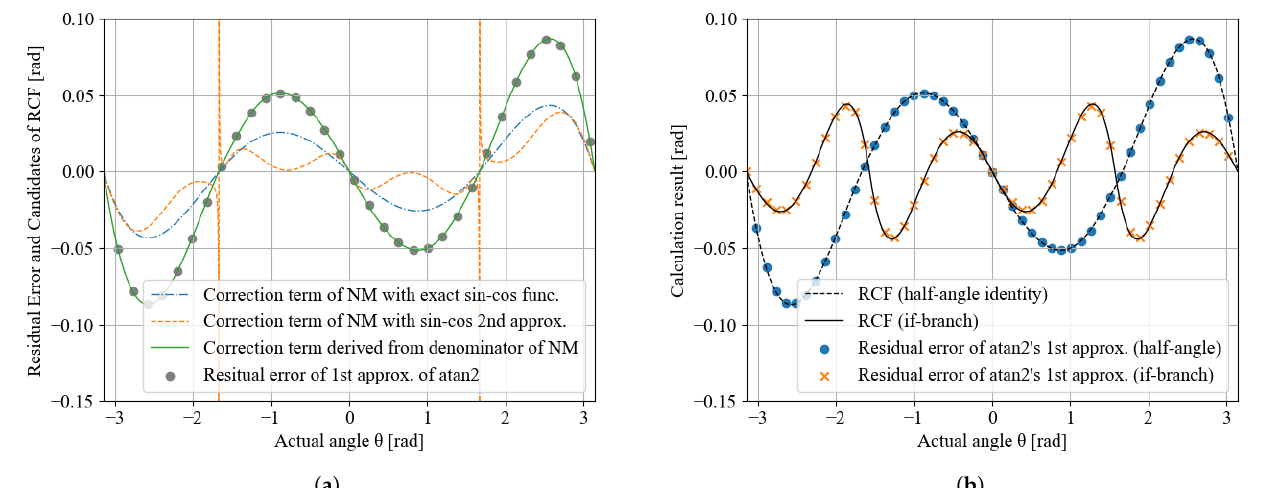
Figure 6. Residual error of atan2’s 1st approximation and consideration of its RCF candidates (plot using x = cos θ , y = sin θ ). ( a ) Evaluation of Newton’s method (NM) for RCF. ( b ) Applying desined RCF for each expansion.